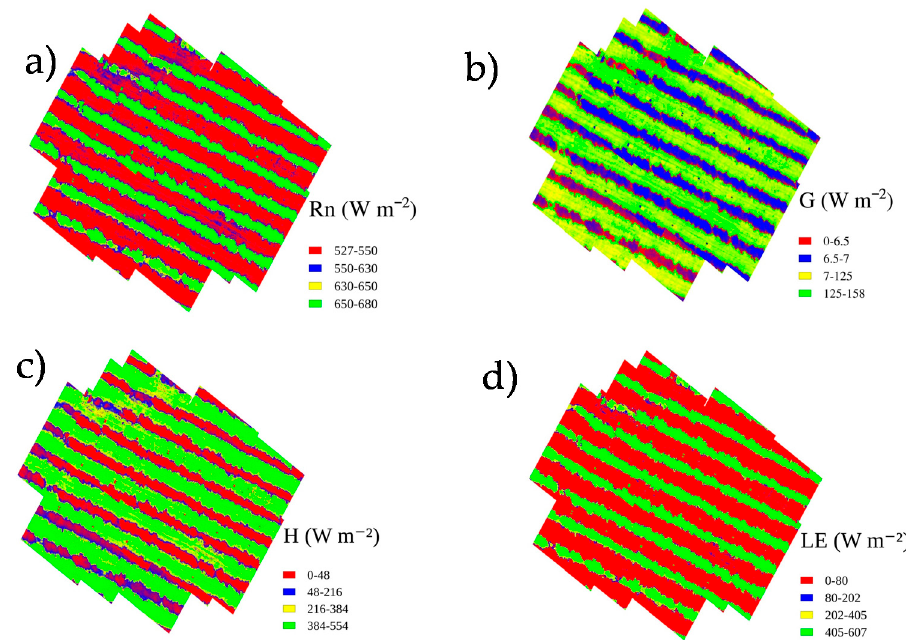
Figure 7. Average spatial distribution of estimated values of ( a ) net radiation (Rn); ( b ) soil heat flux (G); ( c ) sensible heat flux (H); and ( d ) latent heat flux (LE) over the olive canopy and soil surface between rows using a thermal sensor placed aboard an unmanned aerial vehicle (UAV).